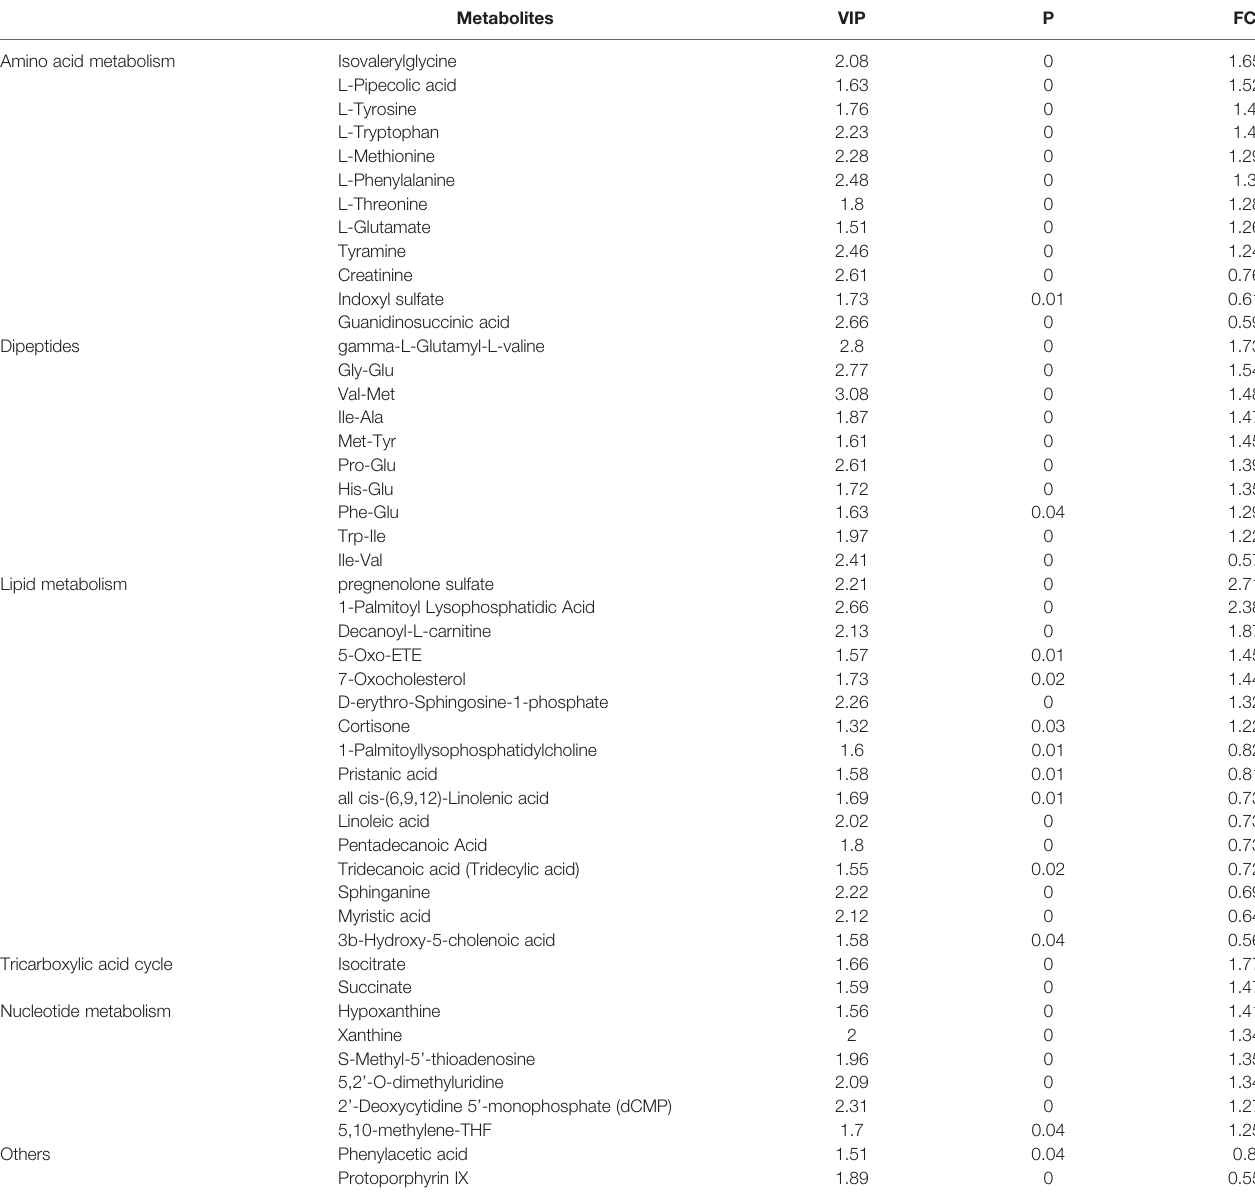
TABLE 2 | Signi fi cantly changed metabolites of GD children compared to controls. Metabolites VIP Amino acid metabolism